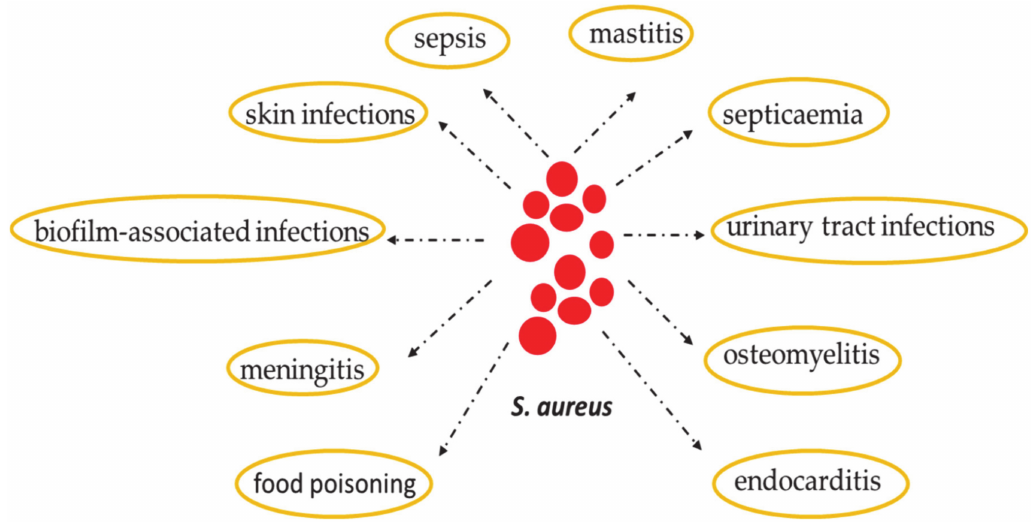
Figure 1. Staphylococcus aureus